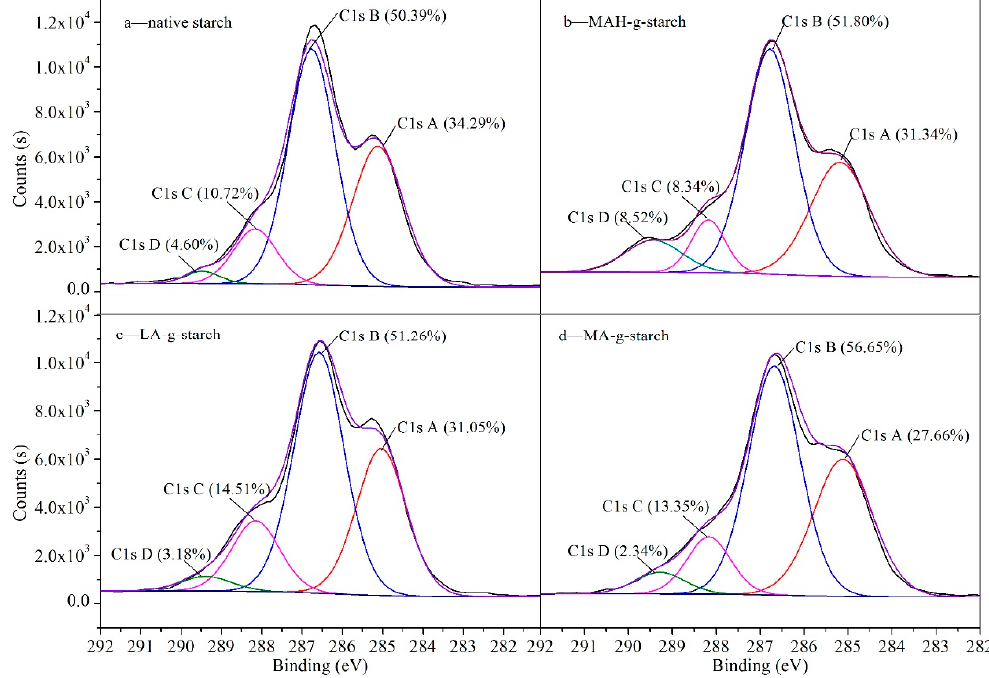
Figure 3. The binding modes and relative content of C in native starch and grafted starches. Table 1. Grafting ratio of three kinds of grafted